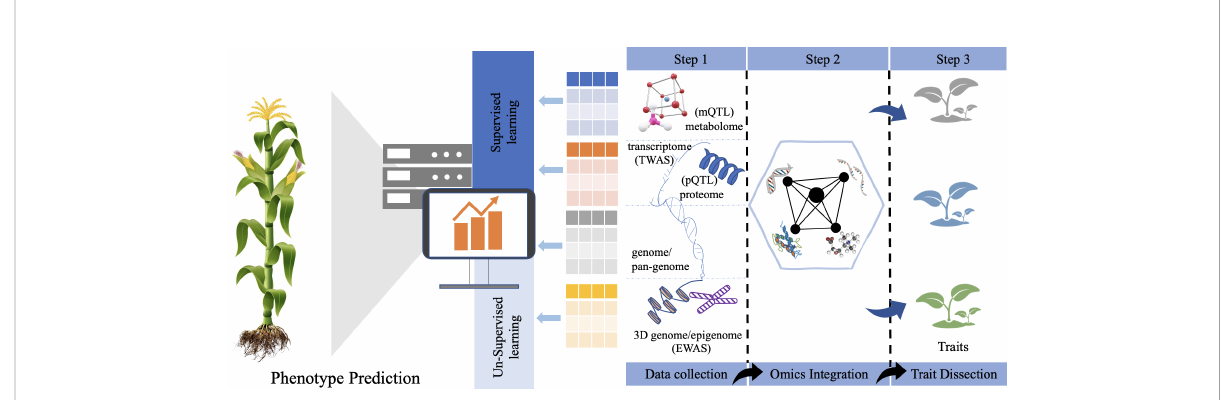
FIGURE 2 Strategies of multi-omics data integration between different layers of omics data to dissect the complex agronomic traits and phenotype prediction by using machine learning methods.